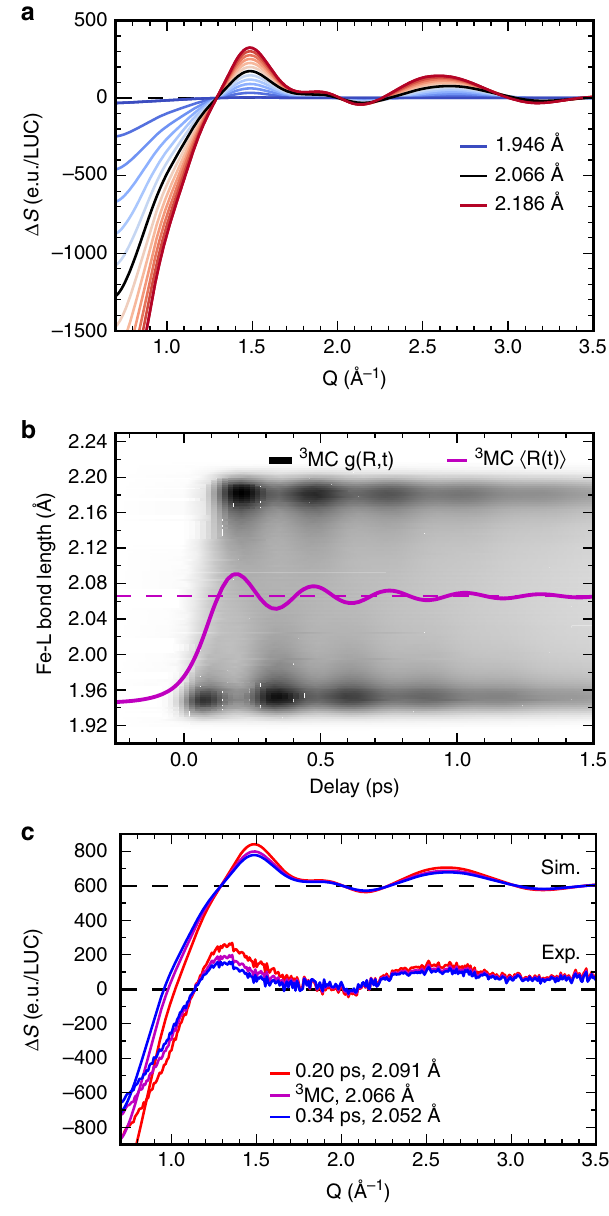
Fig. 5 Simulated solute difference XSS signals. a Dependence of [Fe (bmip) 2 ] 2 + 3 MC difference XSS signal from the average Fe-ligand (L) bond length (including solute-solvent scattering). Black line: optimal 3 MC structure. Blue lines: shorter bond lengths; red lines: longer bond lengths. Respective bond lengths of the curves are from R = 1.946 Å to R = 2.186 Å, step size is 0.02 Å. b Simulated 3 MC bond lengths distribution g ( R , t ) as a function of time (white-black color scale) and the corresponding ensemble average Fe-ligand bond length (magenta solid line). Magenta dashed line: optimal (equilibrium) 3 MC bond length. c Simulation of the time-dependent 3 MC difference signal and comparison to the experimental 3 MC signal extracted from the global fi t (including the oscillatory component). Red line: maximum 3 MC structural expansion at 0.20 ps (< R> = 2.091 Å) Magenta line: optimal 3 MC geometry (< R> = 2.066 Å). Blue line: maximum 3 MC structural contraction at 0.34 ps (< R> = 2.052